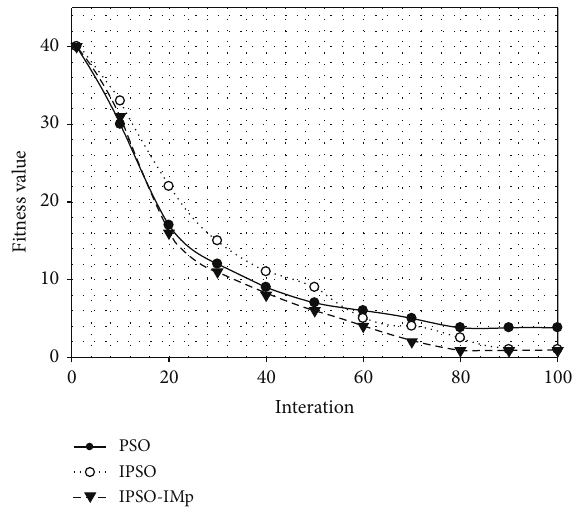
Figure 6: Comparison of different optimization algorithms.